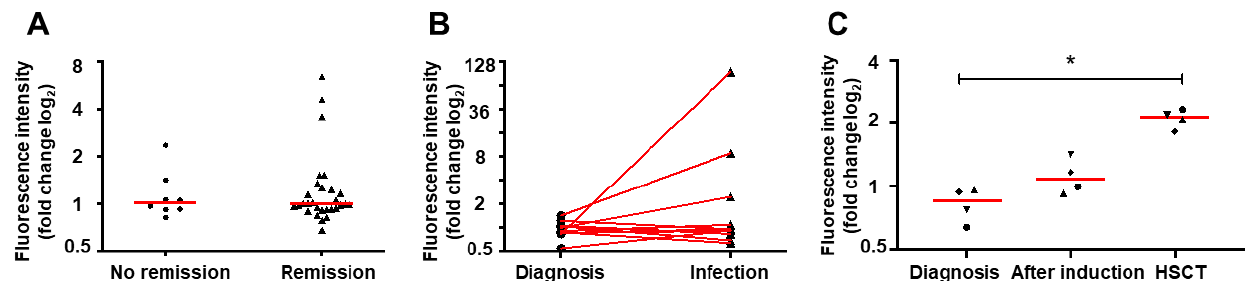
Figure 3. Changes in the neutrophil ability to release NET upon stimulation in different stages of acute leukemia treatment. Each point on the scatter plots represent the result for an individual patient. Red horizonal bars represent median value for each group. Values obtained in repetitive measurements over time from the same patient are connected with red line ( B ) or labeled with the same shape ( C ). In vitro NET formation after induction with PMA in neutrophils isolated from acute leukemia children after induction therapy (day 30–37) ( A ), during acute infection while on treatment in comparison to baseline ( B ), and after hematopoietic stem cell transplant (HSCT) in comparison to baseline and after induction therapy ( C ). Data expressed as a log2 fold change in extracellular DNA fluorescence intensity as compared to non-induced sample. * p < 0.05 in Friedman test for non-normally distributed matched samples with Dunn’s post hoc for multiple com- parisons.